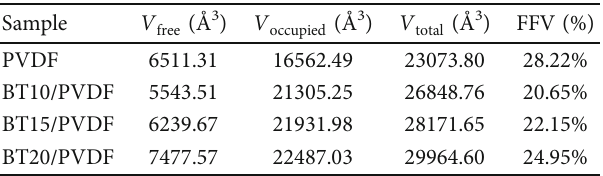
Figure 8: The spatial structure of PVDF (a), BT10/PVDF (b), BT15/PVDF (c), and BT20/PVDF (d) by MD simulation. The free volume is shown in blue, and the occupied volume in gray. Table 3: Free volume